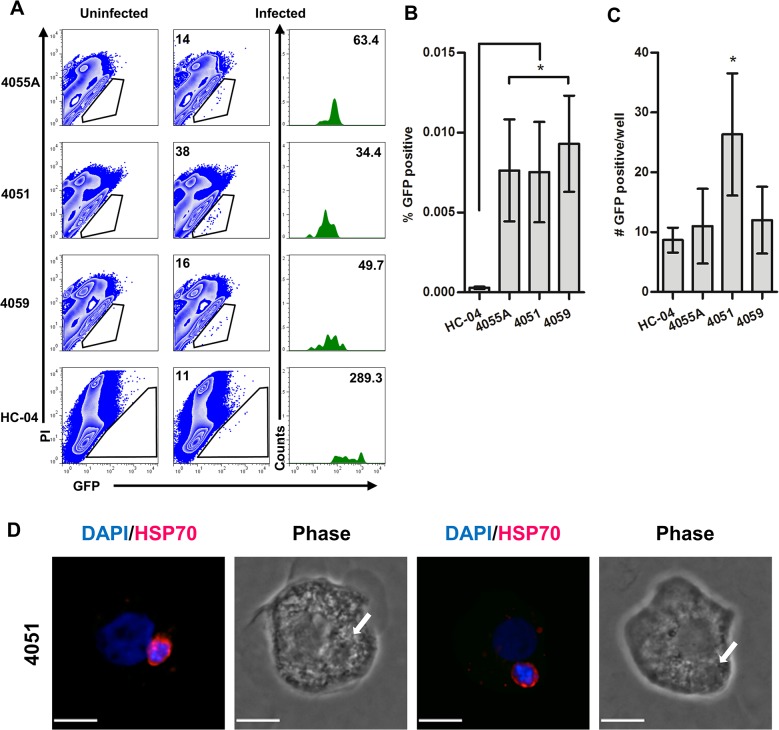
Comparison of detection of P. falciparum infection in primary human hepatocytes and HC-04.Sporozoites were added at a 1:1 sporozoite-to-hepatocyte ratio. Infected cells were identified by flow cytometry at 96 hours postinfection as GFP-positive events in PI-negative (viable) cell populations (n = 3). Uninfected cultures were used to define the positive gates. (A) Representative gating for detection of GFP events using three human hepatocyte donors and HC-04. Number of GFP-positive PI-negative events indicated (middle panels). Geometric mean of GFP-positive PI-negative events indicated (right panels). (B) Comparisons of the percentage of GFP-positive events and (C) total number of GFP events obtained per well. Mean +/- SD shown. (D) Representative examples of GFP-positive PI-negative events isolated by flow cytometry-based cell sorting 96 hours postinfection and cytospun (Scale bars indicate 10 μm).